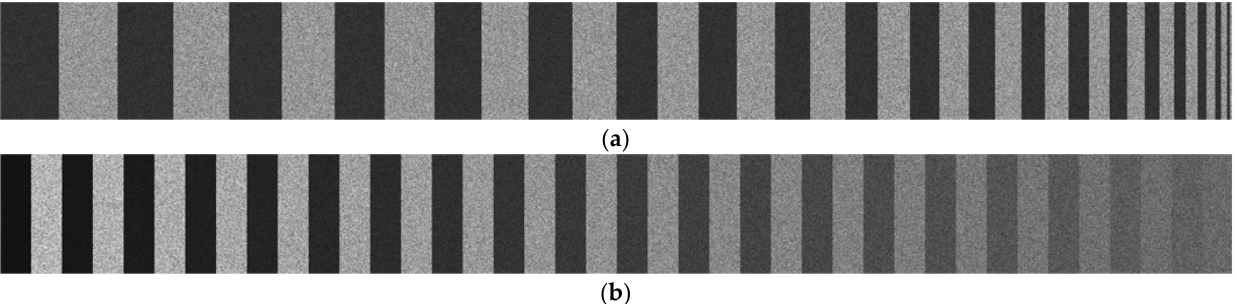
Figure 6. The synthetic images for verifying the performance of the scale-adaptive sliding window sizing method; ( a ) is a synthetic textured image for the positioning accuracy experiment; and ( b ) is a synthetic textured image for the response sensitivity experiment.